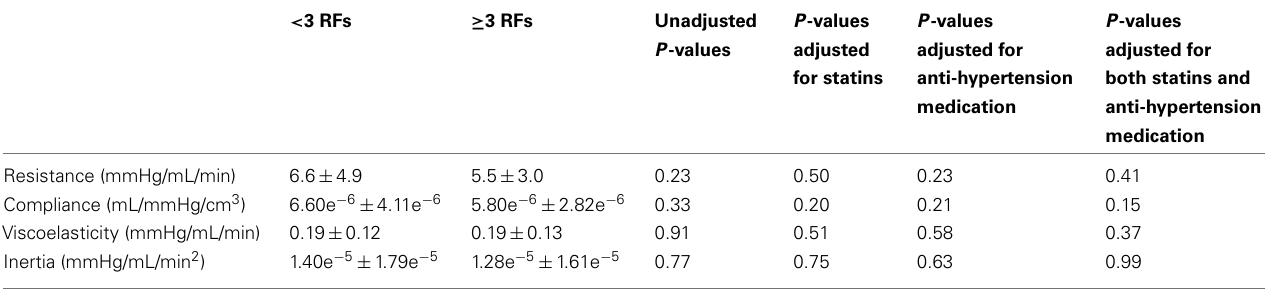
Table 3 | Pulsatile mechanical properties of the forearm vascular